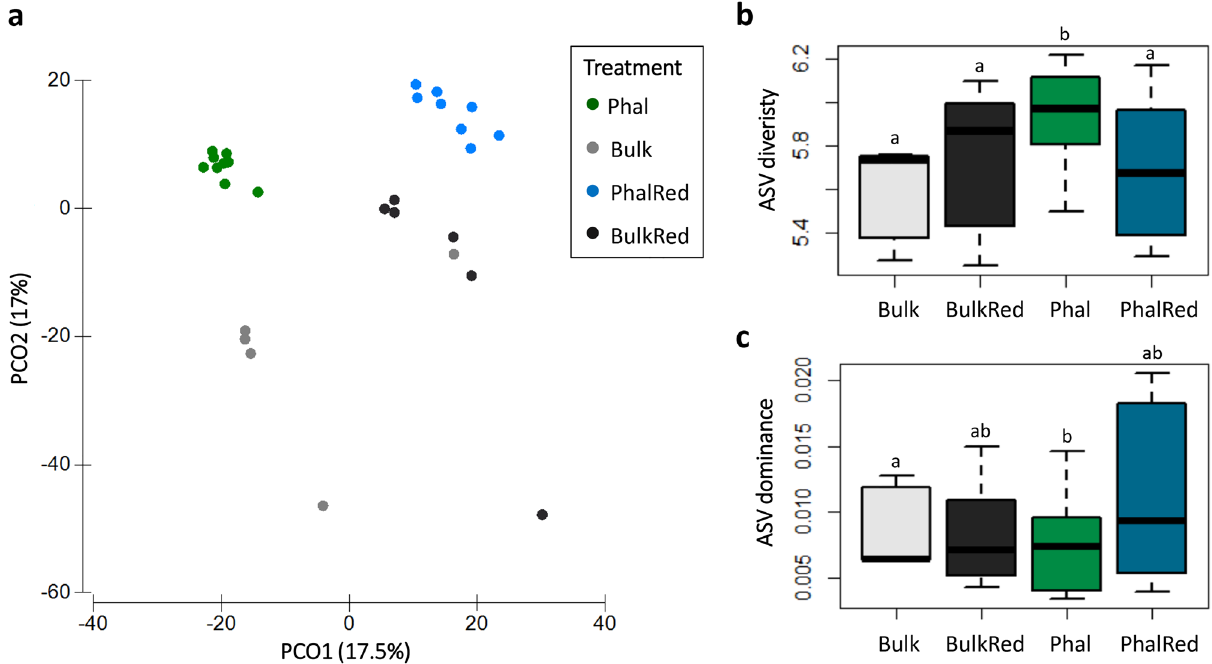
Figure 2. Analysis of bacterial community’s structure and diversity of soil samples after DNA fractioning and sequencing of the main 16S rRNA peak from T 0 and unlabeled SIP incubations. ( a ) Principal coordinates analysis of the ASVs obtained from the bacterial communities according to the different soil treatments. ( b ) ASVs alpha diversity according to Shannon and ( c ) Dominance diversity indices. Letters indicate the statistical differences among time points, according to the analysis of variance